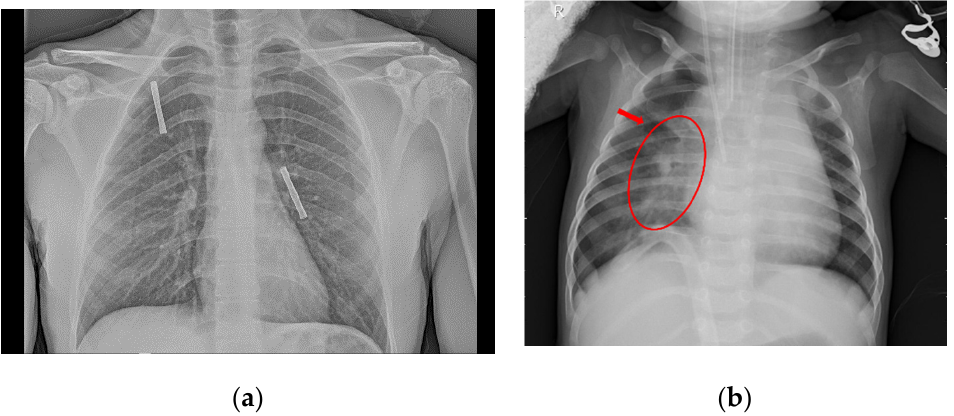
Figure 2. Examples of CXR images: ( a ) shows a healthy patient without any anomaly within the thorax; ( b ) shows a pneumonia-infected patient, fluid and consolidations are found in the right lung. Original images are from (https://github.com/ieee8023/covid-chestxray-dataset) and (https://data.mendeley.com/datasets/rscbjbr9sj/2), respectively. Annotations were manually performed by us with a doctor assistant.